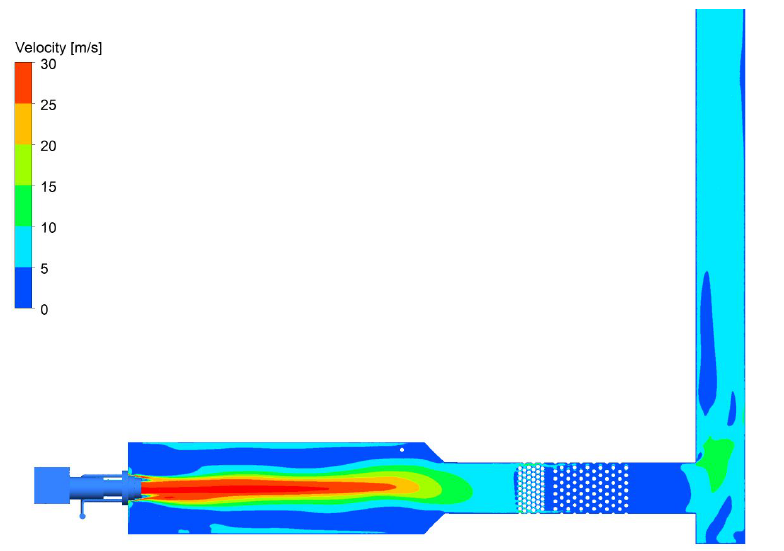
Figure 12. Velocity contour in a vertical cut in the middle of OTSG.